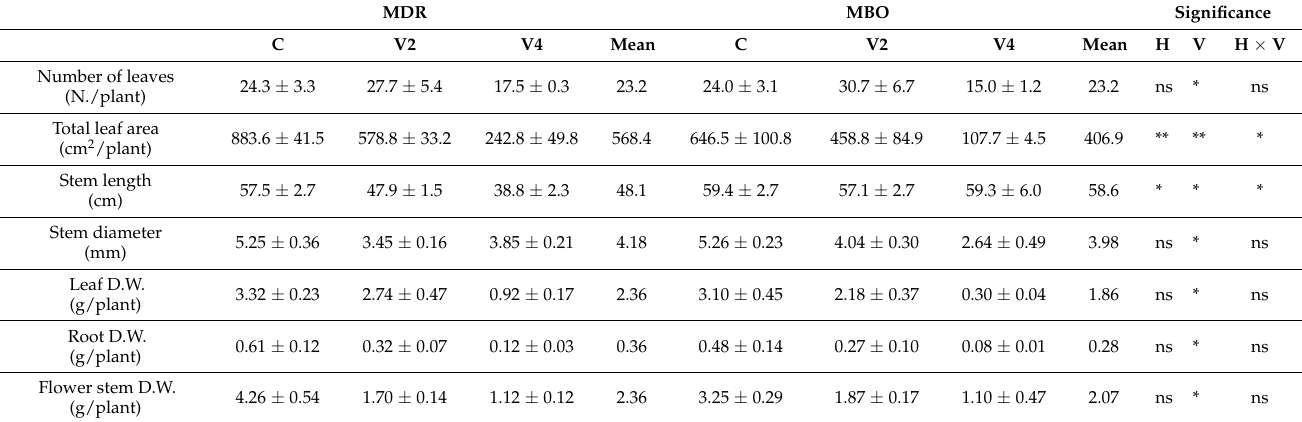
Table 2. Plant growth parameters, flower stem characteristics and dry weight (D.W.) partitioning in Ranunculus asiaticus L. hybrids MBO and MDR obtained by three preparation procedures of tuberous roots, only rehydration (Control, C), rehydration plus vernalization for 2 weeks (V2), rehydration plus vernalization for 4 weeks (V4), and grown in cold glasshouse. Mean values ± Standard errors; n = 5; ns, * and ** indicate non-significant or significant difference at p ≤ 0.05 and p ≤ 0.01. MDR